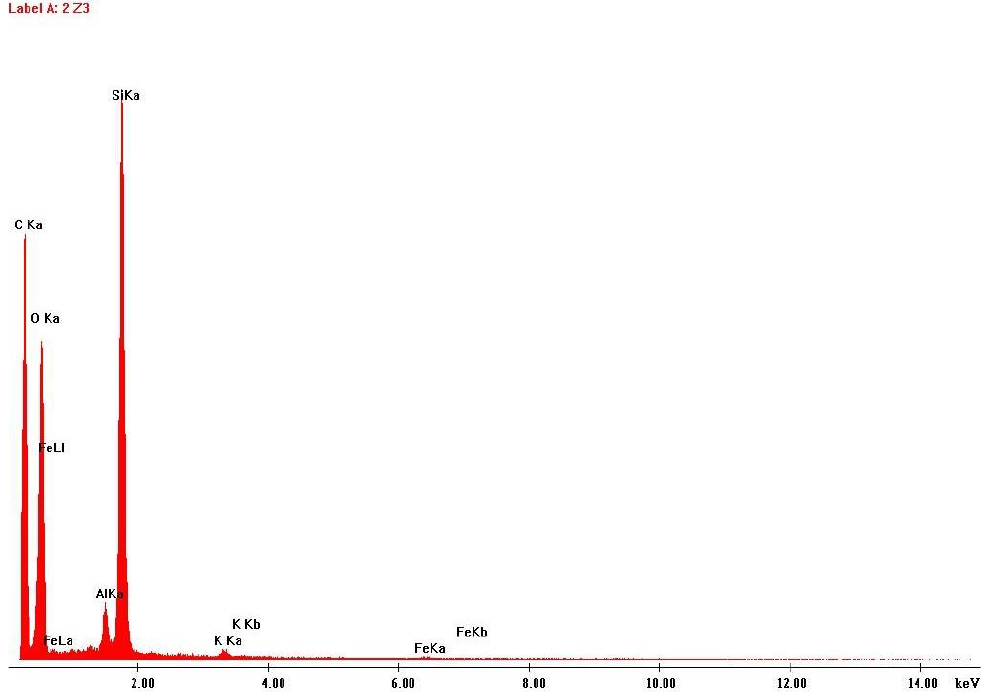
Figure 10. EDS analysis results: Airborne sample collected on polycarbonate filter .